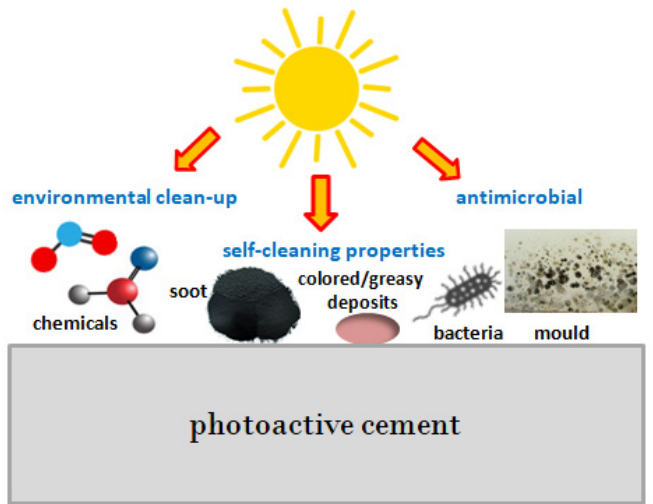
Figure 2. Schematic diagram of multi-functional photoactive cements (based on [49]). (a) Photoactive tests used for determining the photocatalytic efficiency by air purifica- tion